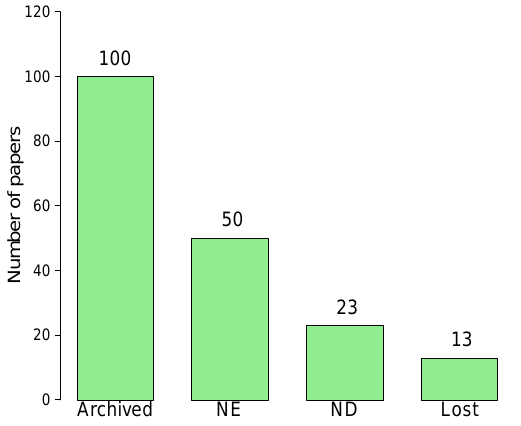
Figure 1. Summary of the data compilation. The number of pa- pers successfully included in the database (archived) versus those in which only one carbonate system variable was reported (NE), papers for which data access was not possible (ND), or for which the data have been lost (Lost).